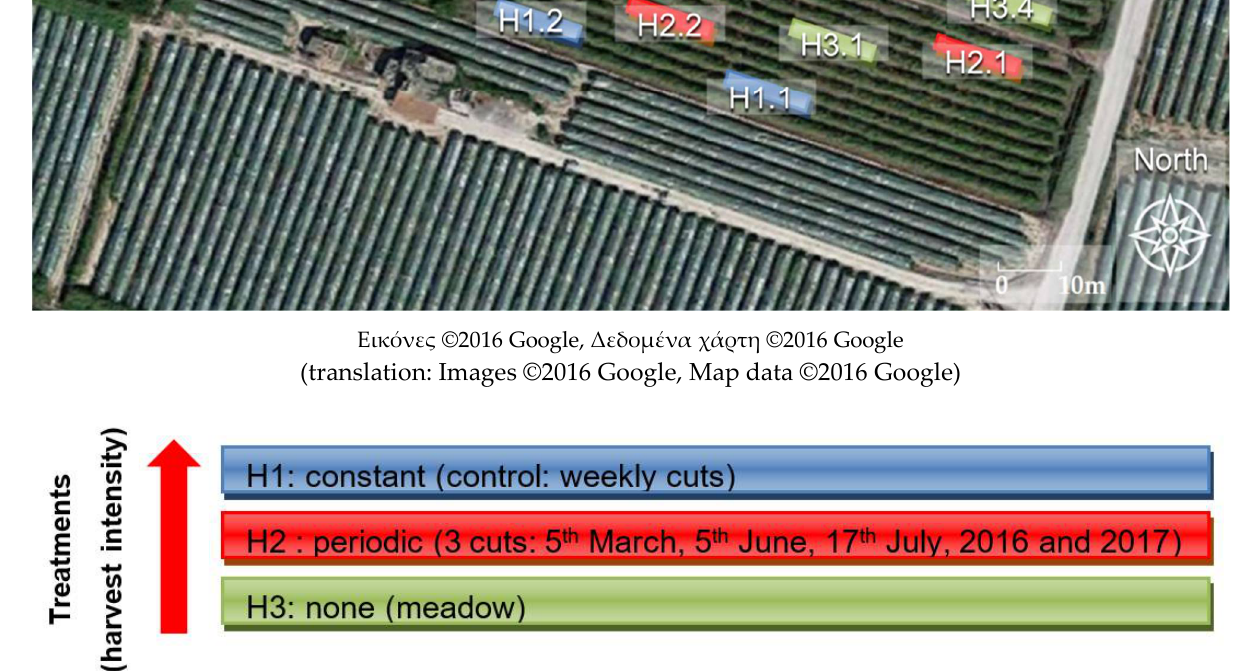
Figure 2. The table variety ‘Sultanina’ vineyard at Perigiali, Korinthia, Greece showing the experi- mental layout constituting 12 plots (marked with different colors; each color indicating a different treatment). The treatments constituted three different harvest intensities (H1, H2, H3) applied to the natural growing meadow (“weeds”) in the inter-rows of the vineyard. Each harvest intensity (treatment) was applied in four plots (source of aerial photograph: Εικόνες ©2016 Google, Δεδομένα χάρτη ©2016 Google; translation: Images ©2016 Google, Map data ©2016 Google).